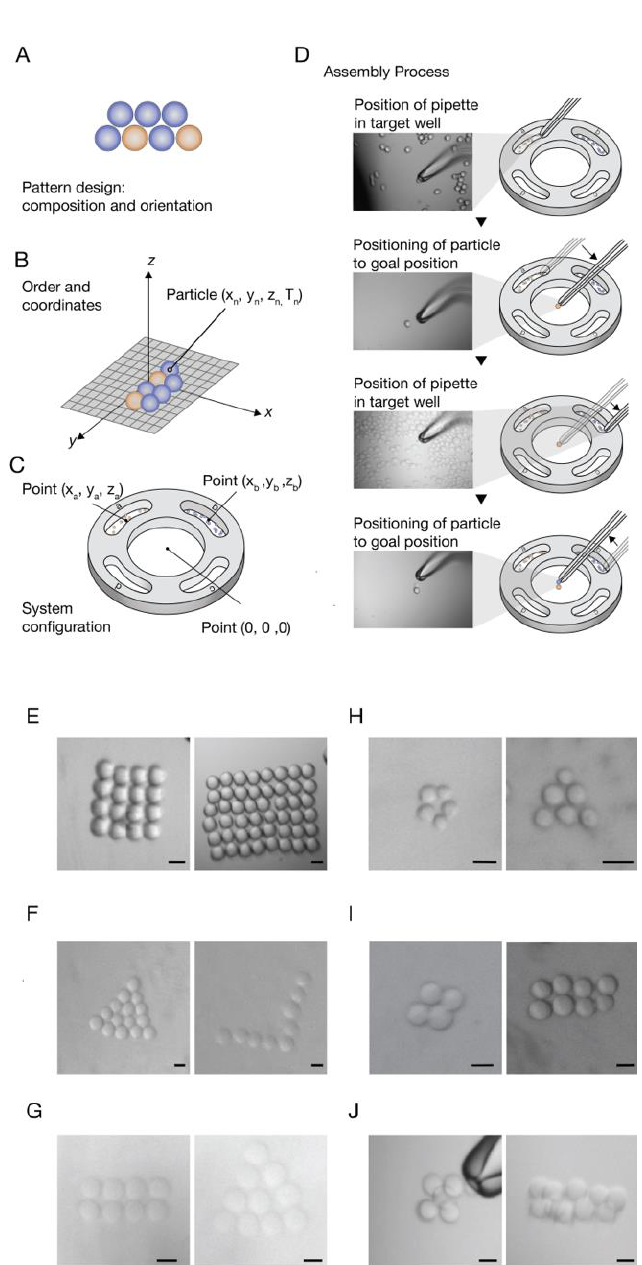
Figure 3. Programmed workflow for patterning of multiple particle types. (A) Plan of the pattern design, composition and orientation of the particles. (B) Conversion of the pattern design to a coordinate format, i.e., defining the displacement order of the particles positioned in the pattern. Next, the particles coordinators are set in relation to the first particle. (C) Defining the coordinate system of the assembly device. The center of the assembly area is set to (0,0,0), and the center of the wells are defined in relation to that point. The first particle in the pattern is placed at that point. (D) The assembly process: the micropipette is inserted into an external well, lifts a single particle each time, and releases it at a precise locus in the central well. Showing two types of beads taken from separate side wells and being placed in nearest proximity in the central well. (E-J) Examples of patterns assembled with our system, for different types of particles: (E) polystyrene beads, (F) Sepharose beads, (G) 3% Agarose droplets. (H) HEP-G2 cells (right) CCL-2 cells (left). (I-J) Sepharose beads coated with complementary DNA sequences. Patterns form one layer (I) and patterns form two layers (J). Scale bars: 30µm.